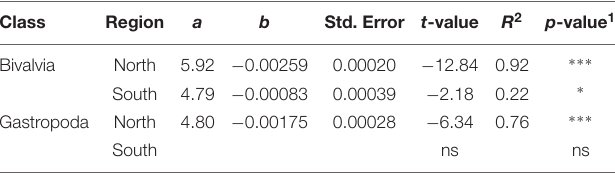
TABLE 1 | Results from least square linear regression models of E ( S 20 ) as a function of depth between 300 and 2000